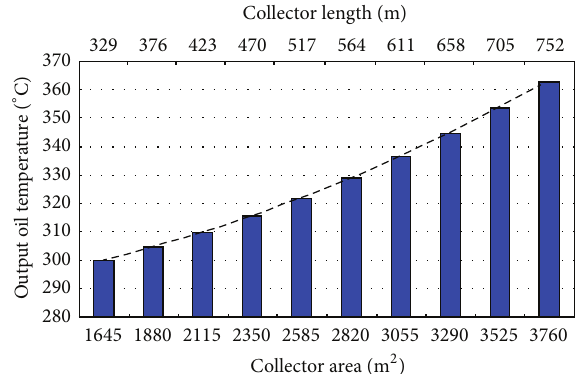
Figure 7: The relation between output oil temperature and solar radiation alterations.